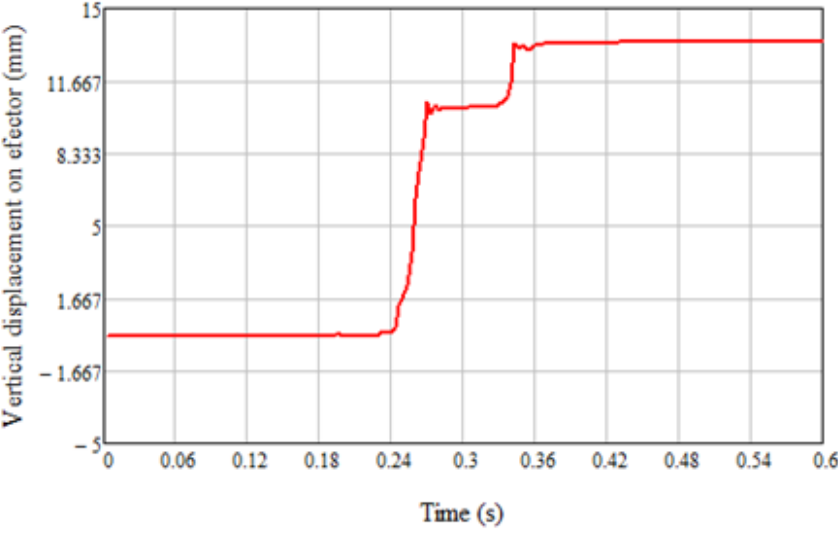
Figure 25. Time variations of axial deformations for the mass of 6.5 kg. The variation in the displace- ment when applying the two weights can be noticed. Approximately at time 0.27 s, a mass of 5 kg was applied, and at time 0.34 s, a mass of 1.5 kg was added.